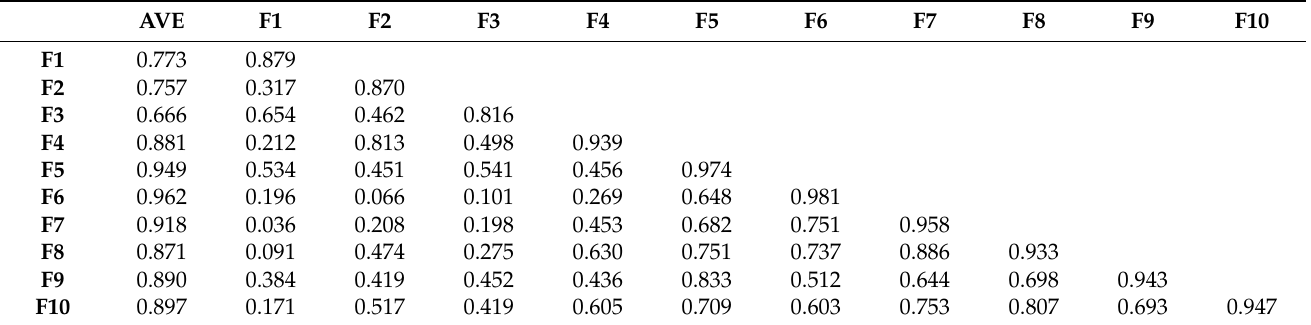
Table 4. Correlations Among All Constructs: Level 2